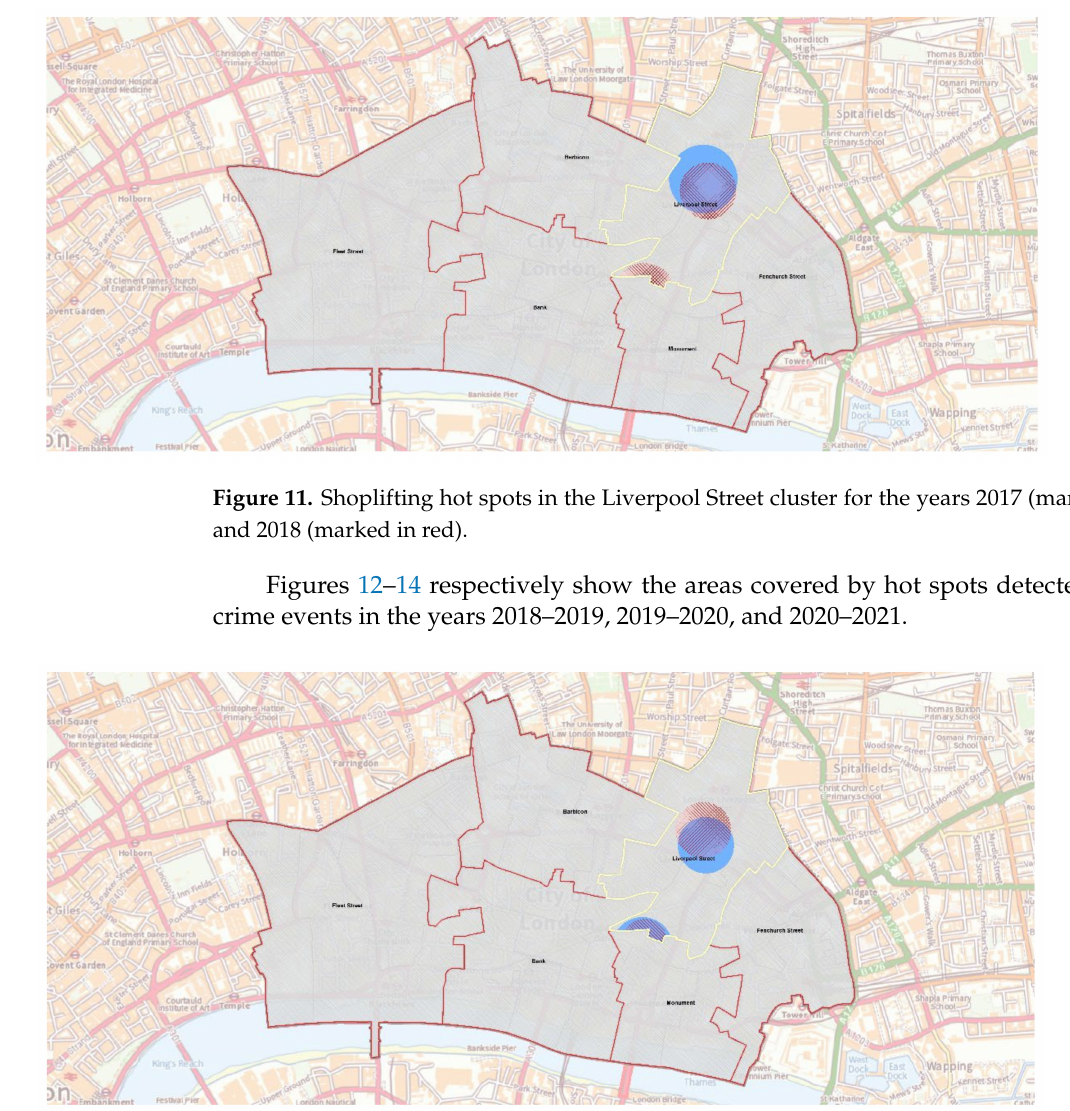
Figure 12. Shoplifting hot spots in the Liverpool Street cluster for the years 2018 (marked in blue) and 2019 (marked in